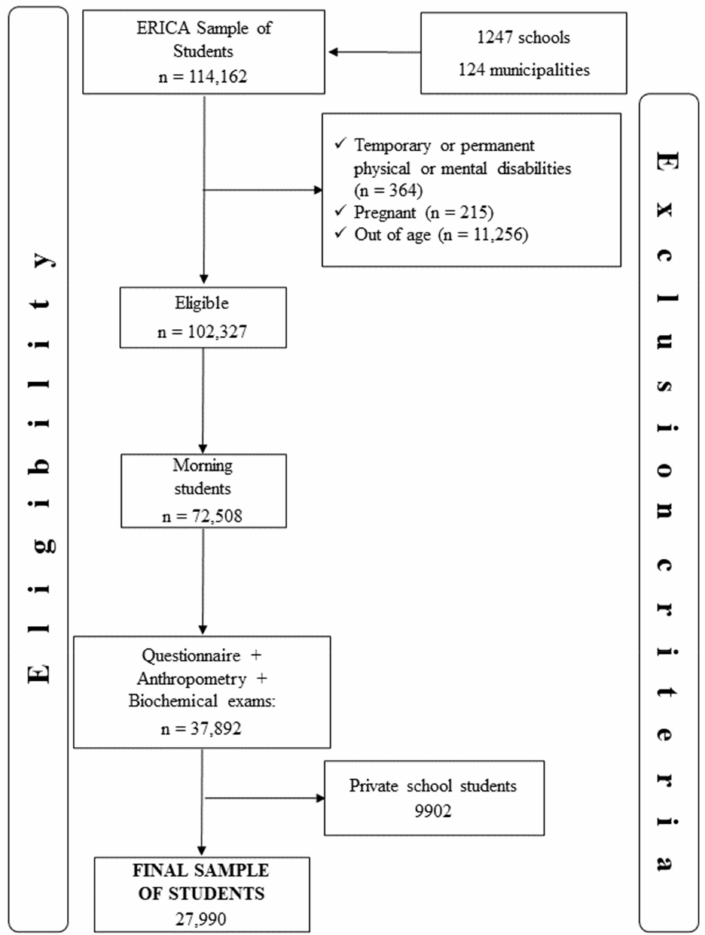
Figure 1. Flow chart of adolescents included. Study of Cardiovascular Risks in Adolescents (ERICA), Brazil,